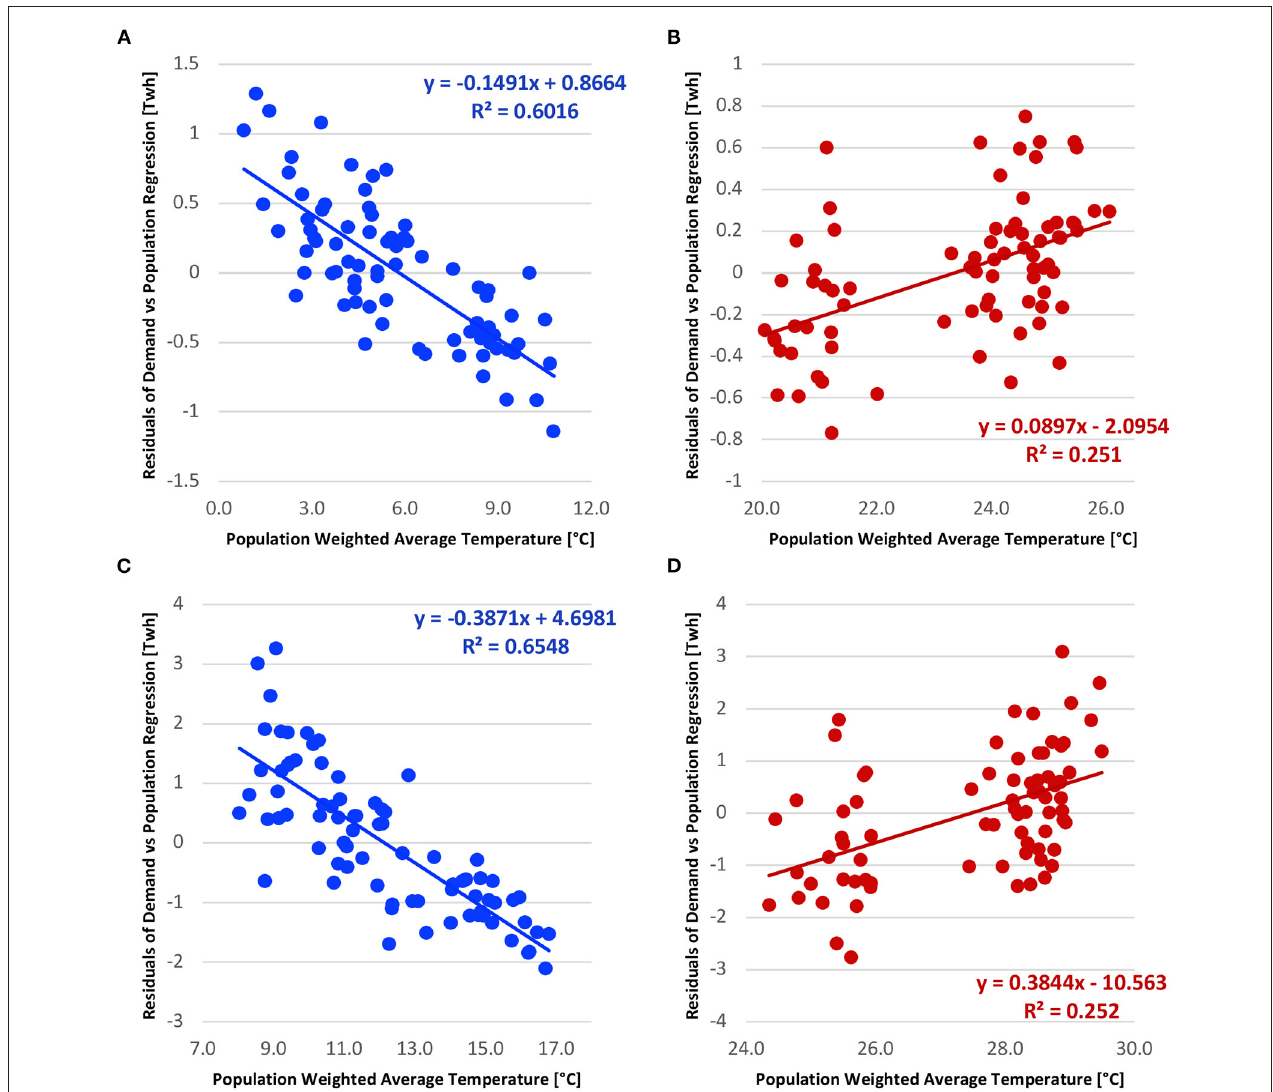
FIGURE 4 | Ability of the bias-corrected CFS seasonal average temperature forecast to explain the interannual variability of residuals obtained from the regression between observed electricity demand and population: (A) TN JFM, (B) TN JAS, (C) TX JFM, and (D) TX JAS. Residuals corresponding to winter (summer) months are indicated in blue (red)